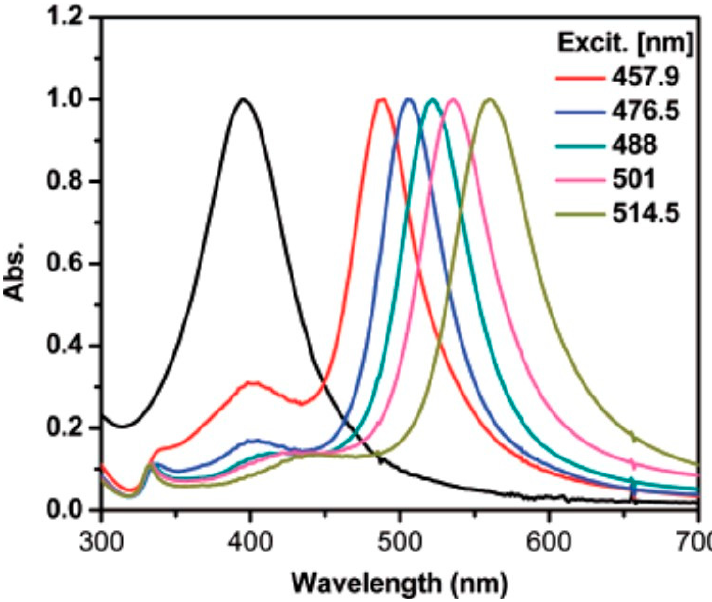
Figure 6. SPR bands from Ag NPTs irradiated by Ar-ion laser lines. Reprinted with permission from ref. [31] . Copyright 2007 American Chemical Society.